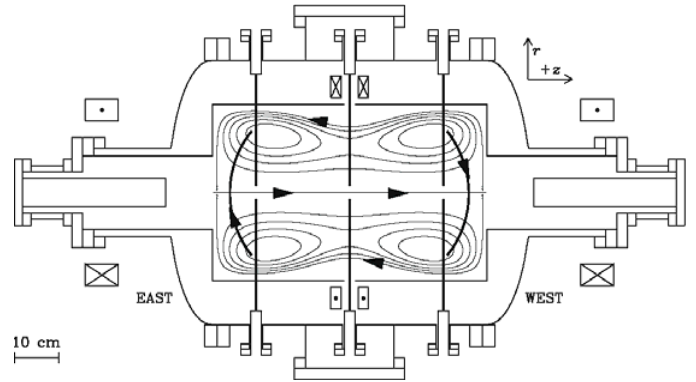
Figure 15. The Swarthmore Spheromak Experiment